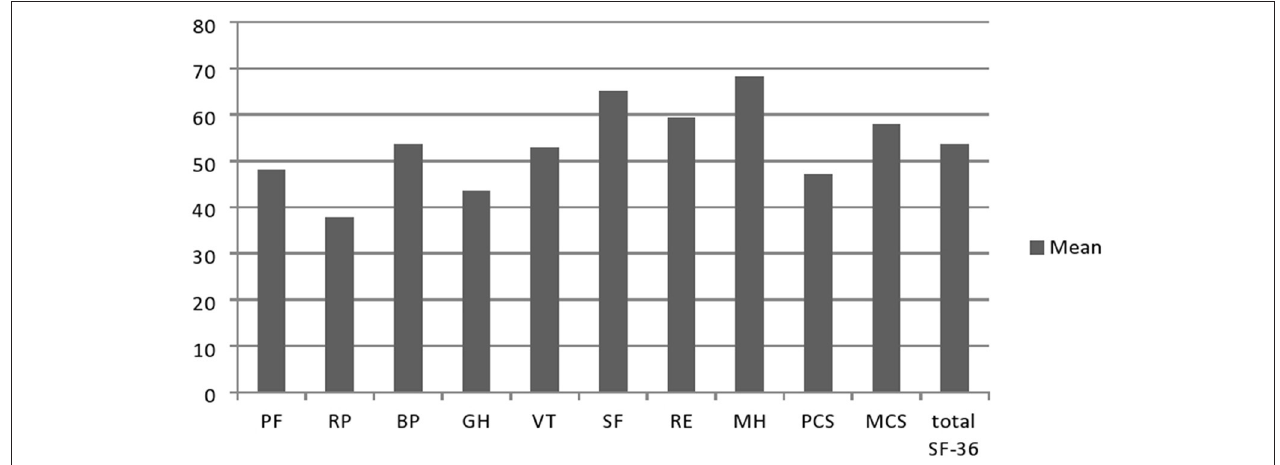
FIGURE 1 | Results on the SF-36 questionnarie in Serbian CMT1A patients ( n = 45). PF, physical functioning; RP, physical role; BP, bodily pain; GH, general health; VT, vitality; SF, social functioning; RE, emotional role; MH, mental health; PCS, physical composite score; MCS, mental composite score.